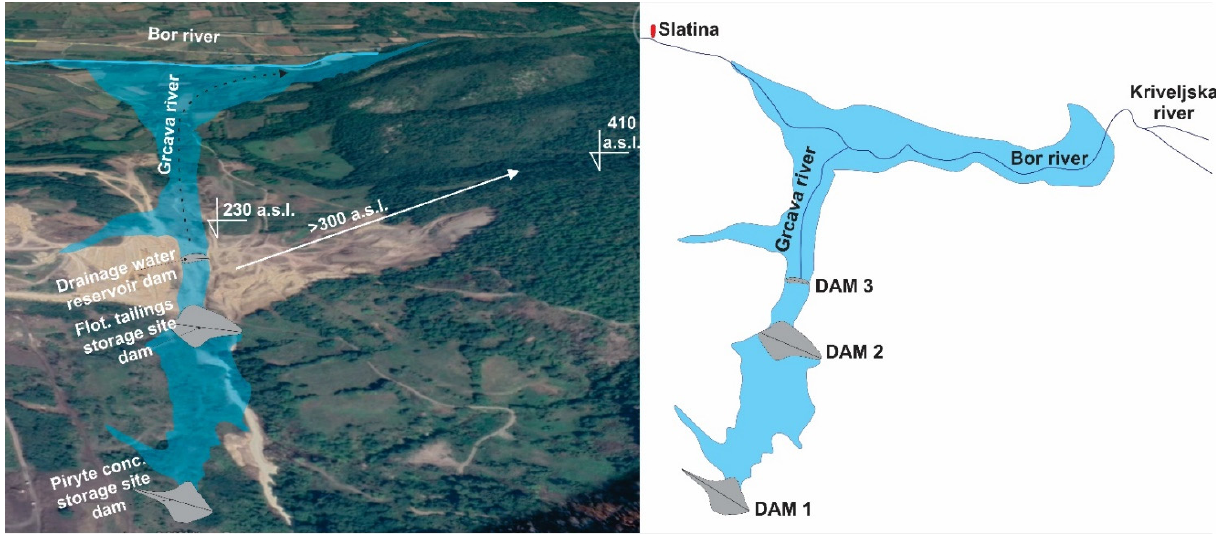
Figure 9. Route of the flood wave outlined on the basis of the blue zone obtained with HEC-RES software; on the left side: A display of topography of the terrain along which the flood wave moves, from the starting point of the flood wave; on the right side: A drawing of the flood zone, viewed from above, not to scale [20]. Reproduced with permission from author and publisher Mining and Metallurgy Institute Bor (MMI Bor), Serbia Zijin Mining doo Bor, Detailed Mining Design –